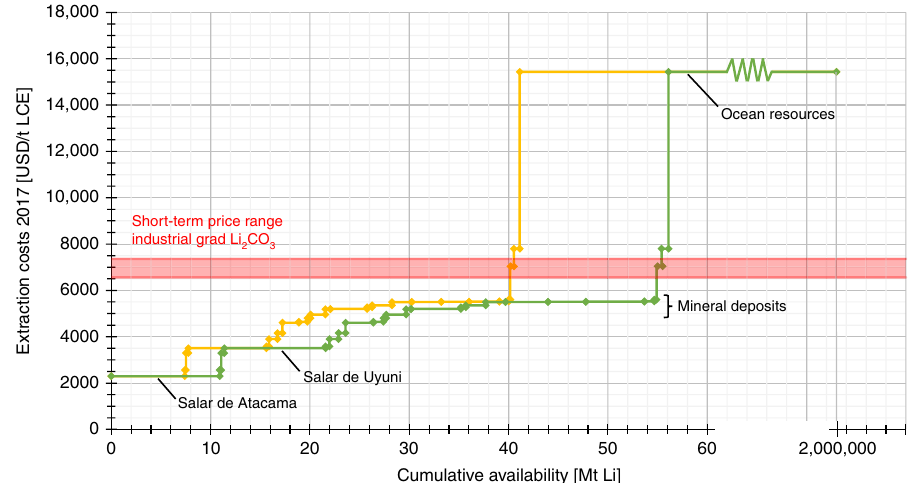
Fig. 1 Cumulative availability curve of global Li resources. The availability curves of this study ’ s medium (yellow line) and high resource values (green line) are plotted. Both reveal four major plateaus. Beginning with cost leading Salar de Atacama, South America ’ s second major brine, Salar de Uyuni, accounts for the next horizontal line. The majority of mineral deposits follow at some distance. The date at which society must switch to these more expensive deposits depends on the amount of available resources. This equally applies to the shaping leap to ocean resources, the height of which, in turn, depends on the extraction costs of Li from seawater. Current estimates suggest different values framing a range of 3 20, 27 − 30 26 times the usual costs of pegmatites and brines (Supplementary Table 6). The red coloured area marks the expected short-term price range for industrial grade lithium carbonate. Nearly all conventional deposits are below. As a consequence, the values for presumed medium and high resource assumptions are economically justi fi ed. Note that the extraction cost estimate on y -axis is per lithium bicarbonate equivalent